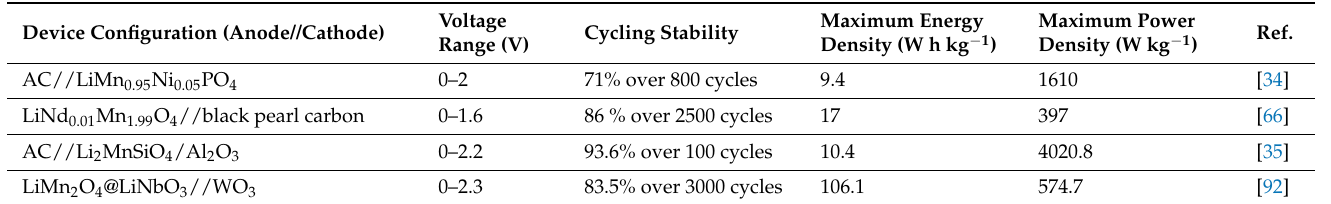
Table 3. Summary of energy/power densities of LICs on basis of doped manganese-based material.